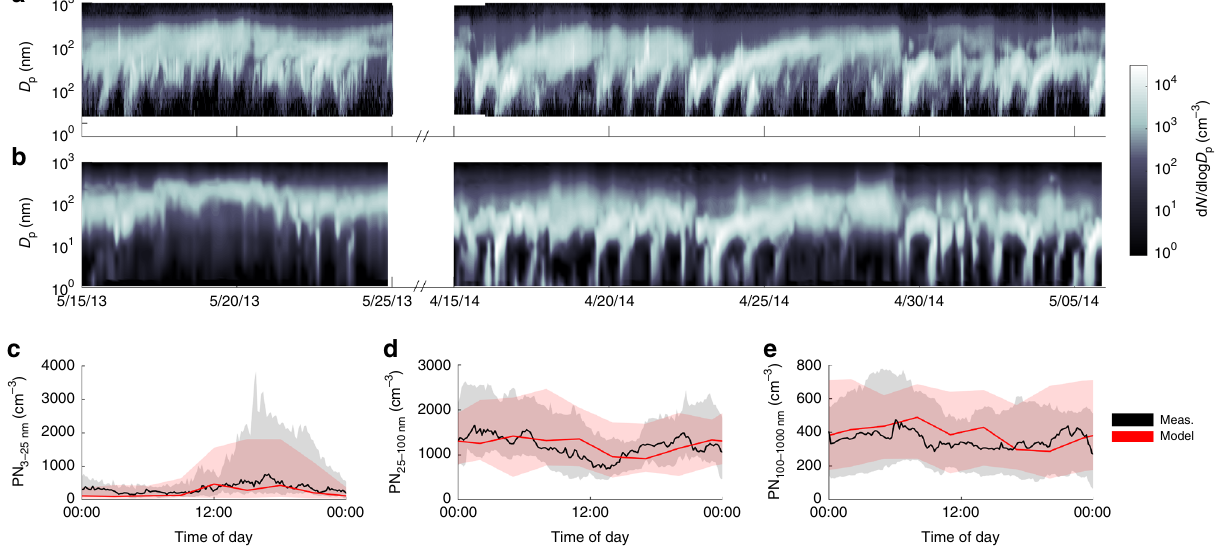
Fig. 5 Aerosol particle number concentrations. Measured and modelled particle number concentrations at the Station for Measuring Ecosystem- Atmosphere Relations II (SMEAR II) from the periods 15 – 25 May 2013 and 15 April to 5 May 2014. Panels a and b show the measured and modelled particle number size distributions respectively. Panels c , d and e show the measured and modelled median diurnal cycles of particle number concentrations in the nucleation mode (3 – 25 nm in diameter, PN 3 – 25 nm ), Aitken mode (25 – 100 nm in diameter, PN 25 – 100 nm ), and accumulation mode (100 – 1000 nm in diameter, PN 100-1000 nm ) respectively. The shaded areas illustrate the measured (grey) and modelled (pink) ranges within the 25th and 75th percentiles. The particle number size distributions were measured with a differential mobility particle sizer